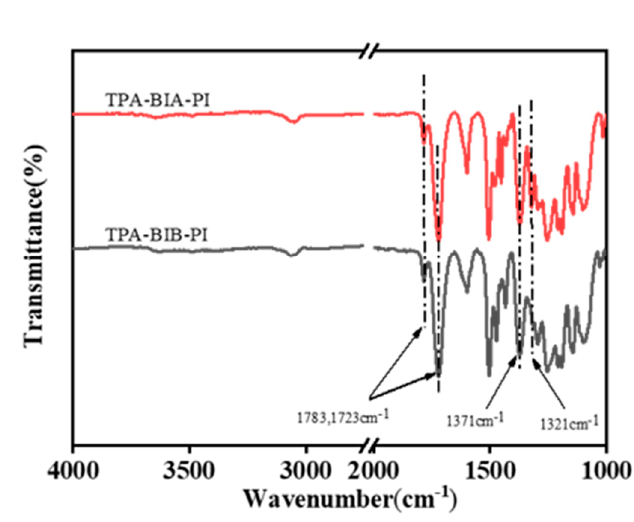
Figure 3. FT-IR spectra of the polyimides.